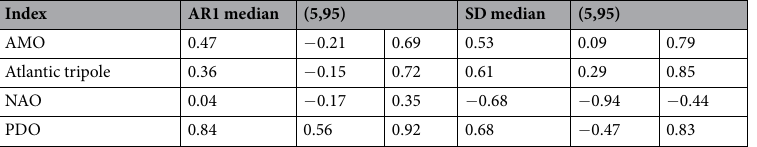
Table 1. Autocorrelation and variance trends in observational climate indices (1957–2002). Trends expressed as Kendall τ values. Medians as well as 5 and 95 percentiles from the estimated distributions (varying filtering bandwidth and sliding window length) are reported.